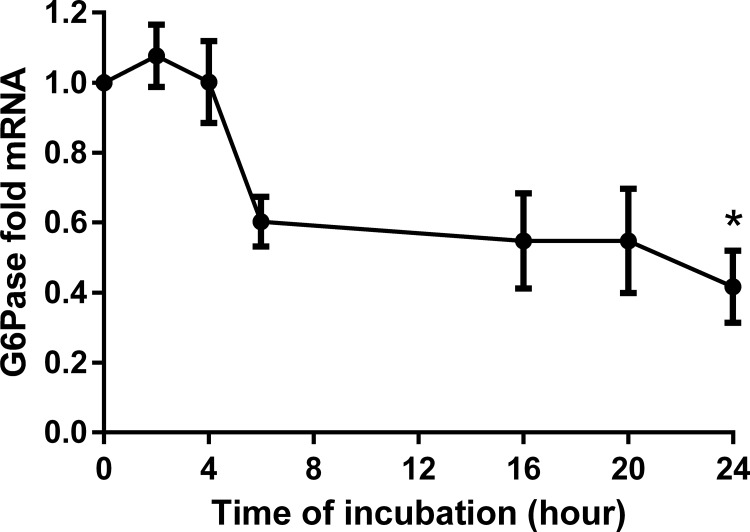
G6Pase time dependency analyses in HepG2 cells modulated by BITC.Time dependency analyses upon stimulation with BITC 30 μM is shown for G6Pase. Fold mRNA expression was normalized to the housekeeping gene RPL32 and control (0 hours), the control value is unity. One way ANOVA was used for the nonlinear regression analyses. Data shown as mean value ± SEM of gene expression versus control *(p<0.05).